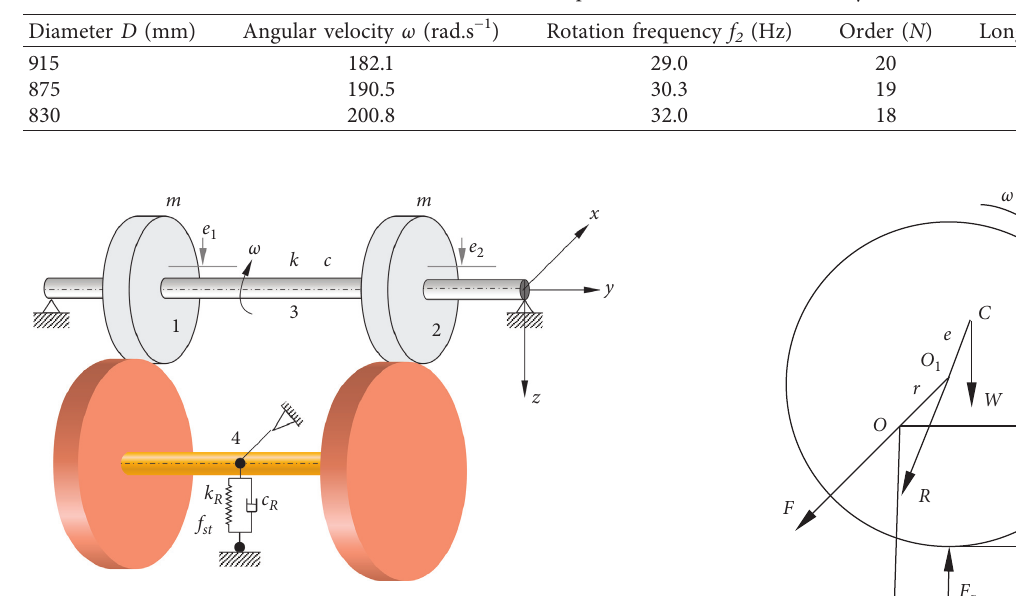
Table 1: Calculation parameters of wheelset rotor system.